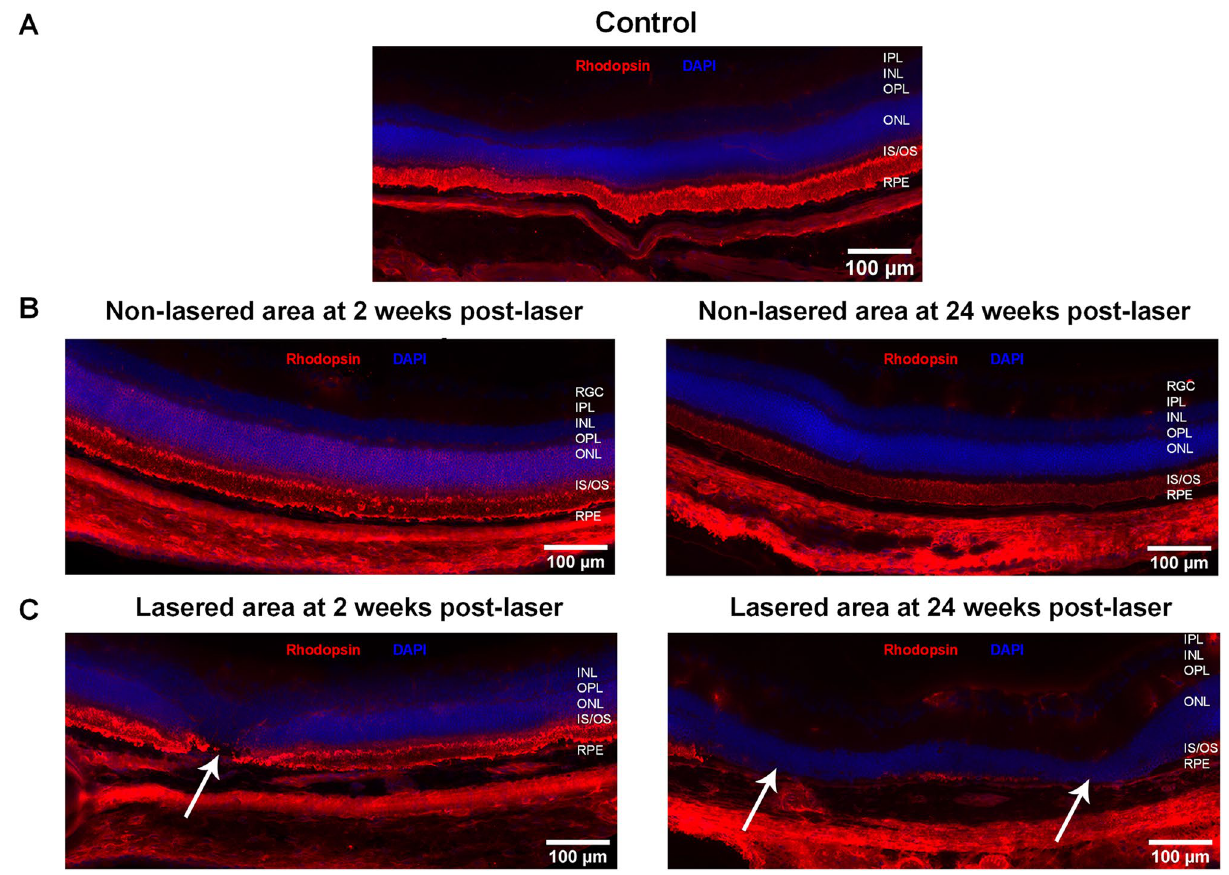
Figure 6. Rod photoreceptor damage after induction of RLCS. Representative immunofluorescence images of chorioretinal tissues from ( A ) control mice; ( B ) non-lasered areas of retina and ( C ) corresponding laser spot areas at 2 weeks (left) and 24 weeks (right) after laser treatment to induce a RLCS. Retinal sections were probed with anti-rhodopsin (red) and stained with DAPI (blue). Tissues show evidence of the absence of rod photoreceptors at the laser lesion sites (white arrows). Rod/photoreceptors remained unaffected in non-lasered areas. Retinal ganglion cell layer (RGC); inner plexiform layer (IPL), inner nuclear layer (INL), outer plexiform layer (OPL), outer nuclear layer (ONL), photoreceptor inner segment/outer segment junction (IS/OS), retinal pigment epithelium—Bruch’s membrane interface